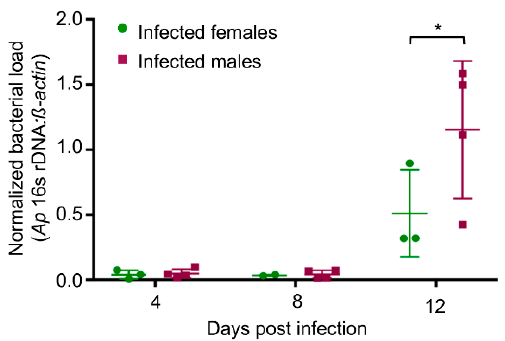
Figure 1. A. phagocytophilum infected male mice exhibit higher peripheral A. phagocytophilum DNA levels than female mice. Male and female C57Bl/6 mice were intraperitoneally injected with A.